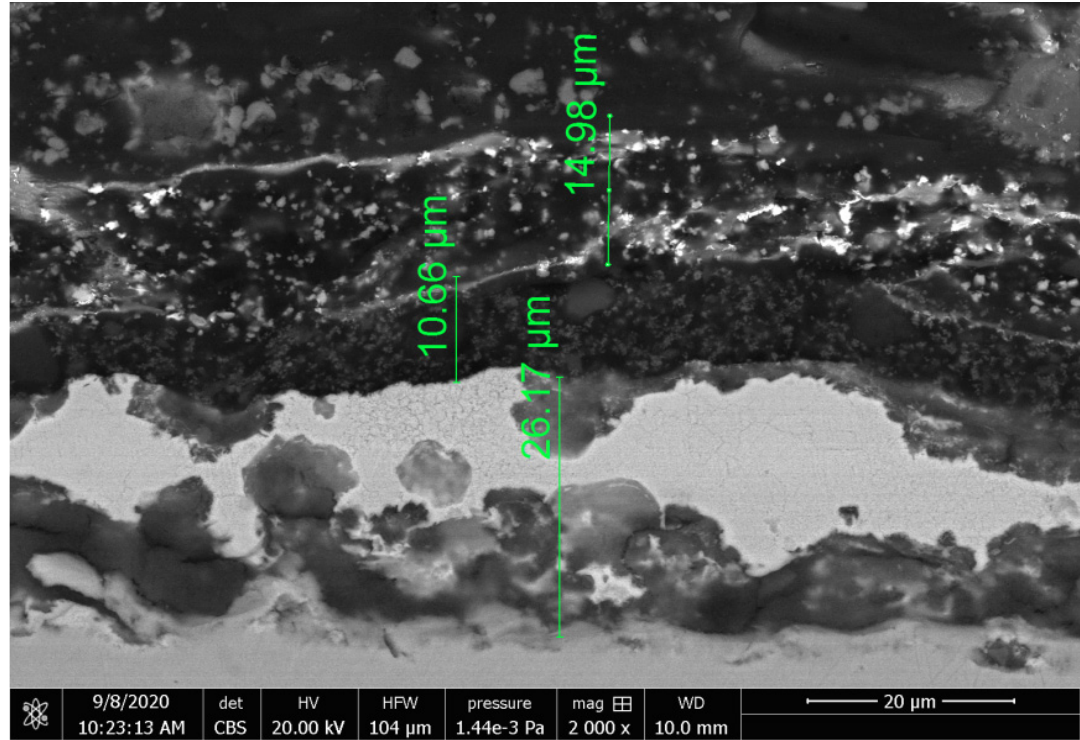
Figure 5. SEM image of the cross-section of the ZA200 coating (“black”).